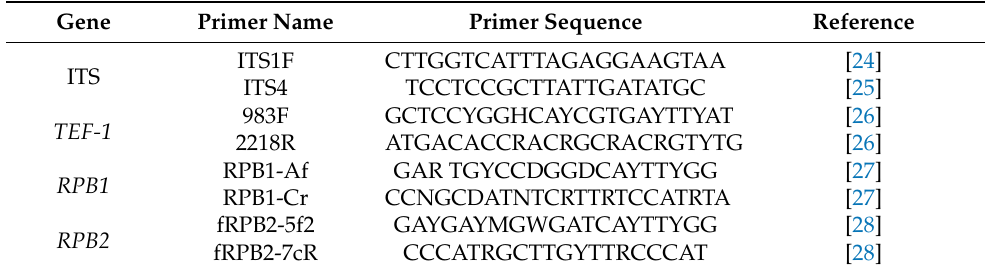
Table 1. Primers used in this